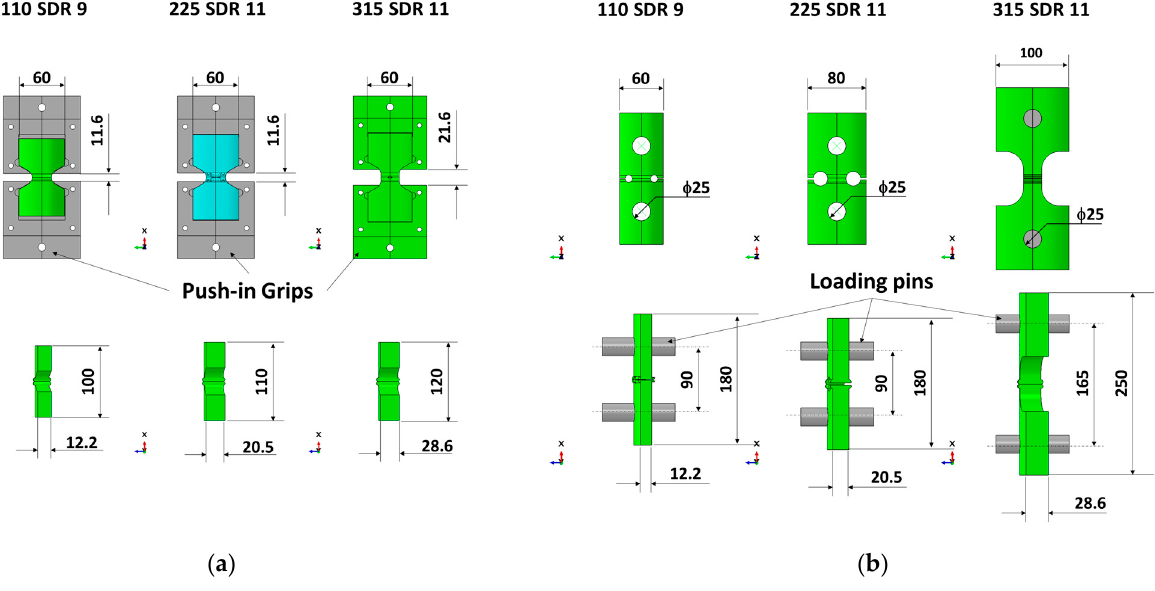
Figure 12. 1/4 Finite element models and data collection lines along the longitudinal direction from the center of the BF joint to the tip of the specimen (unit: mm): ( a ) Type A model (110 SDR 9); ( b ) Type B model (315 SDR 11); ( c ) points of interest. The true stress–strain data of PE100 utilized for the FE analysis is shown in Figure 13. The true stress–strain data up to the onset necking was estimated from the nominal stress–strain data using Equations (1) and (2). An exponent value of n = 1.25 was chosen as it gave an optimal curve passing through the true stress and strain data points (open circles) obtained from the real-time experimental measurement of the cross-sectional area and the length change during the tensile deformation, as shown in Figure 13. The inde- pendent elastic constants (i.e., E = 1.1 GPa, σ y = 18.5 MPa, ε y = 0.03037, and ν = 0.45) were used to describe the elastic part. The plastic part after the yield strength was tabulated from the fitted true stress–strain curve.